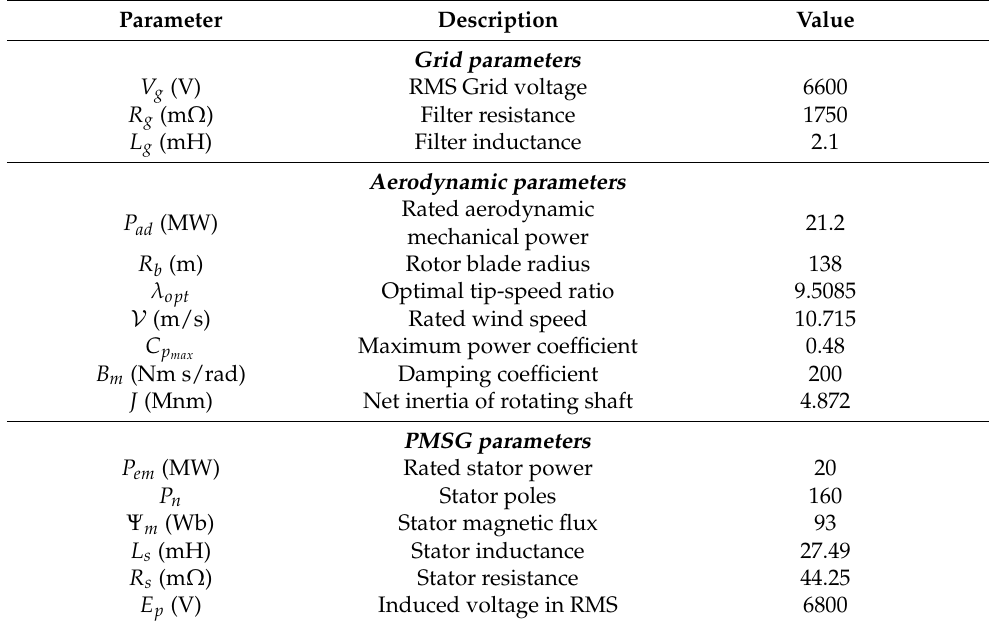
Table 1. Parameters of 20 MW PMSG-based